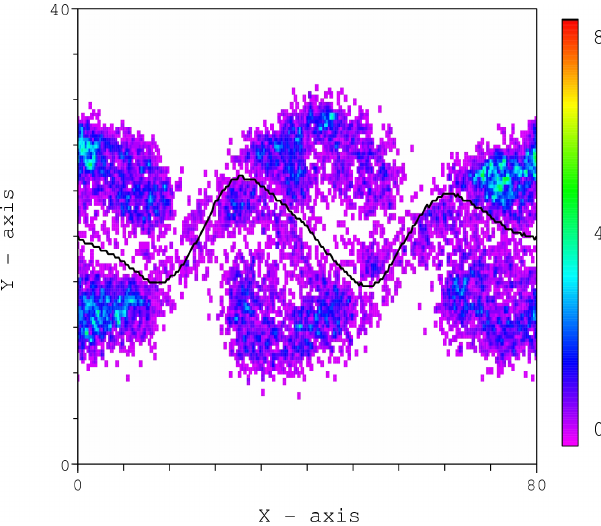
Fig. 5. Color-coded Y component of the magnetic field depending on the Kx mode (after spatial Fourier transformation) and time. The solid thick line is the time evolution of the derivative of δZ .